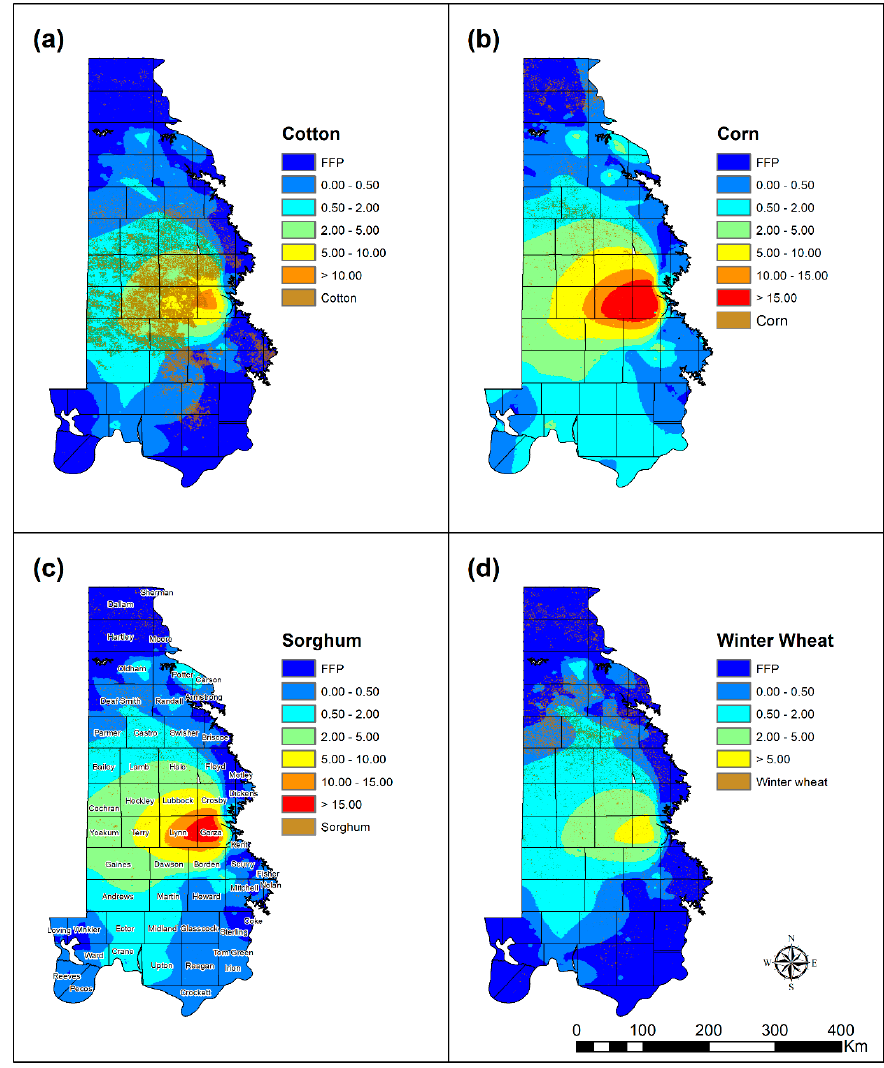
Figure 11. Overall Compatibility Index (OCI) for agricultural use: ( a ) cotton, ( b ) corn, ( c ) sorghum, and ( d ) winter